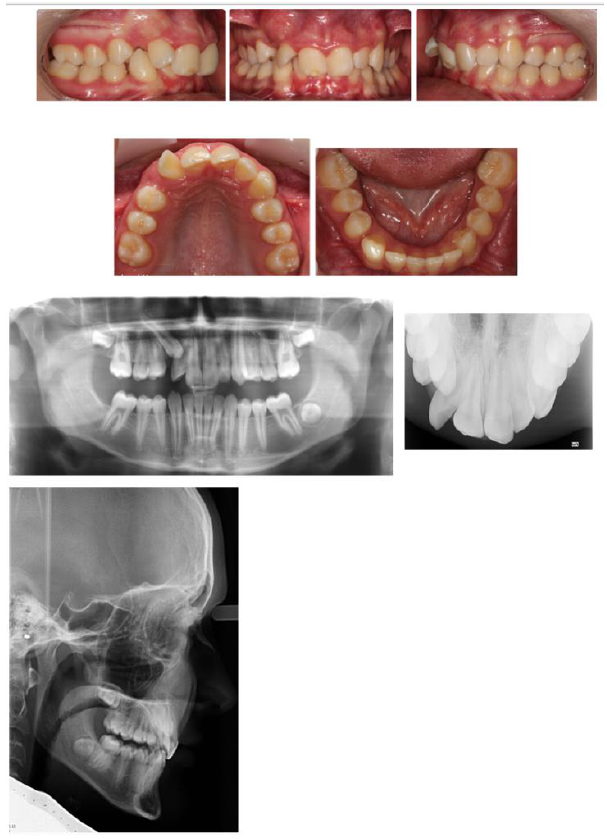
Figure 5. Pre-treatment intraoral photographs and radiographs. The extraction of all molar incisor hypomineralisation (MIH)-affected FPMs was carried out at the age of 9. Note the congenitally absent LR8.